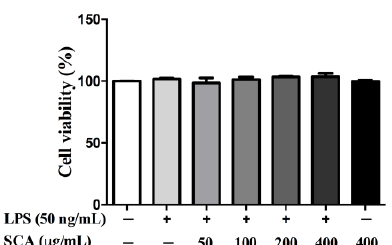
Figure 2. Effect of SCA on the viability of RAW 264.7 macrophages. RAW 264.7 macrophages were treated with SCA at the concentrations of 0, 50, 100, 200 and 400 μg/mL, respectively, for 1 h, and then stimulated with 50 ng/mL lipopolysaccharide (LPS) for 24 h. RAW 264.7 macrophages were also treated with SCA at the concentration of 400 μg/mL without LPS for 24 h. Cell viability was detected by cell counting kit-8 (CCK-8) assay.